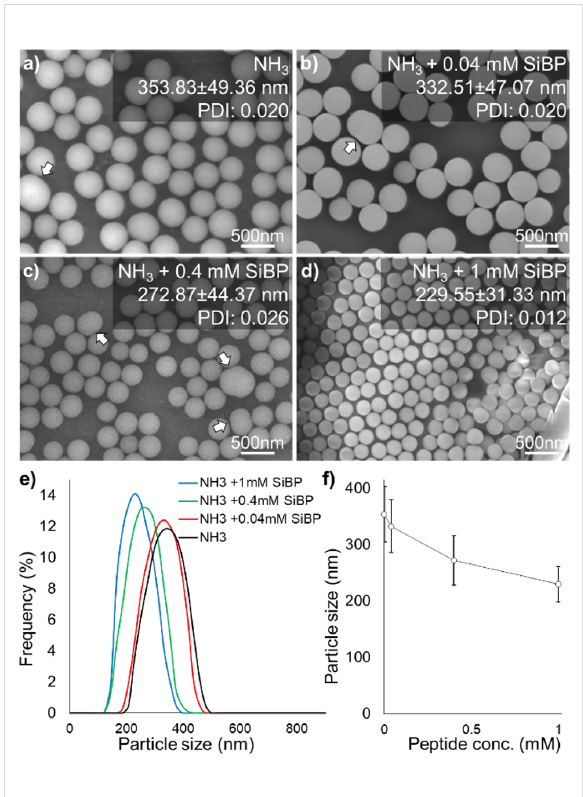
Figure 3: SEM images and size distributions of the particles formed with (a) NH 3 only and NH 3 with (b) 0.04 mM, (c) 0.4 mM, and (d) 1 mM SiBP (arrows: coalescing particles). (e) Particle size distributions ob- tained from DLS measurements. (f) Effect of SiBP on the particle size when NH 3 was